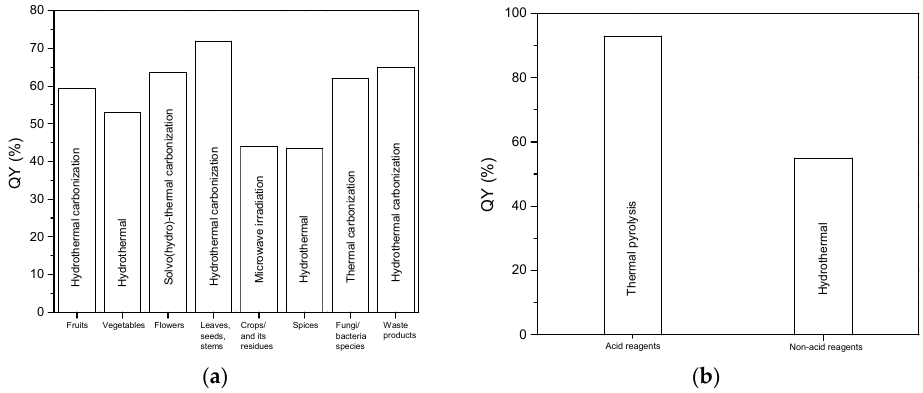
Figure 9. Quantum yields of the CDs based on ( a ) green precursors and ( b ) chemical precursors.